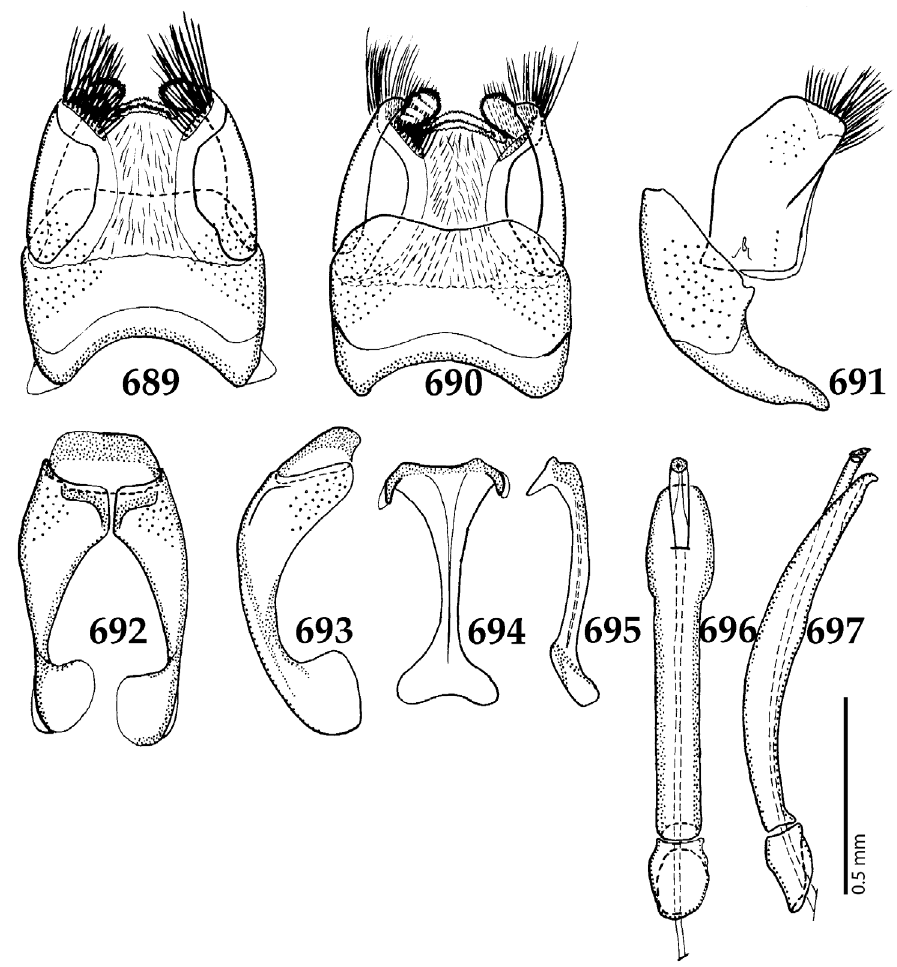
view 693 ditto, lateral view 694 male terminalia: spiculum gastrale, ventral view 695 ditto, lateral view 696 male terminalia: aedeagus, dorsal view 697 ditto, lateral